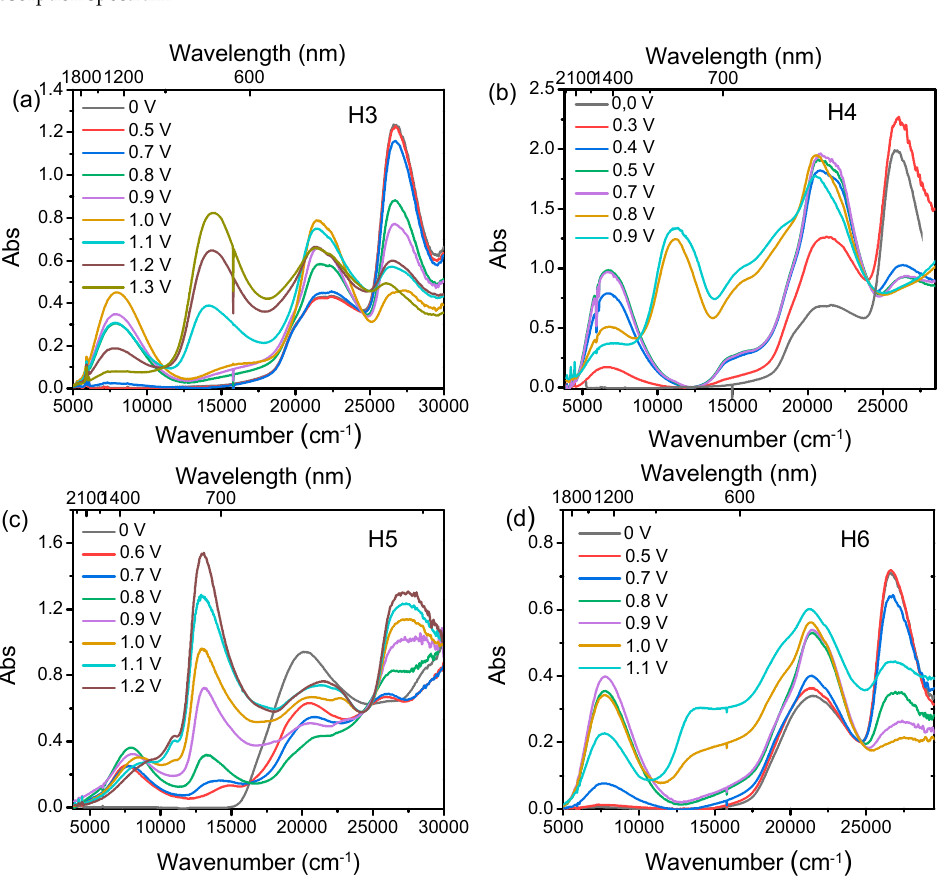
Figure 3. Spectroelectrochemistry of H3 ( a ), H4 ( b ), H5 ( c ) and H6 ( d ) at c = 10 − 3 M in CH 2 Cl 2 /0.1 M TBAPF 6 , at oxidative potentials.